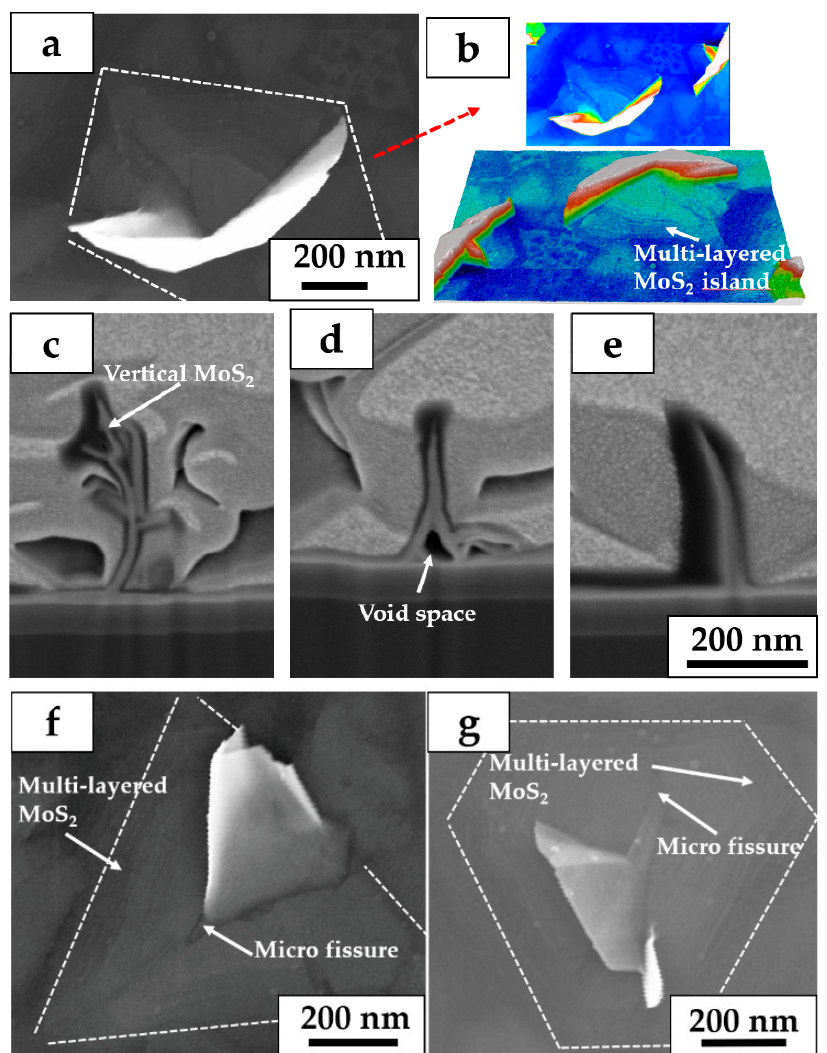
Figure 5. Typical growth morphological evolution of vertical MoS 2 structures. ( a ) Vertical seedlings originate from the aggregation zone of two MoS 2 islands due to the compressive forces between them ( b ) A three-dimensional representation of aggregation zone between different multi-layered MoS 2 islands, the light blueish green color represents the multilayered structures and the red color represent the vertical sheet. ( c – e ) Cross-sectional FIB image of vertical MoS 2 structures with different morphological features. ( f , g ) The formation of vertical seedlings from the micro fissure appears on individual MoS 2 islands.